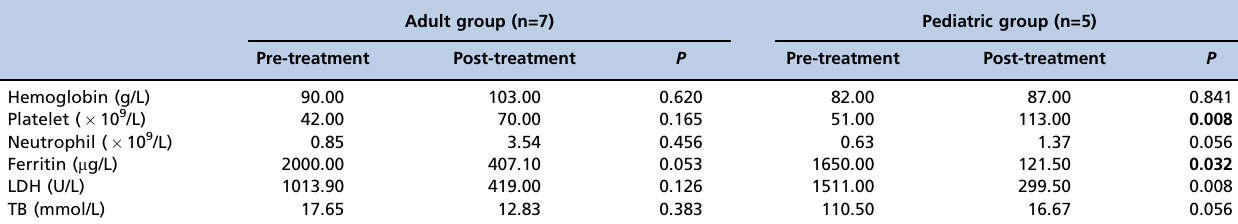
Table 3 - Changes in laboratory findings between diagnosis and after 2-3 weeks of treatment with the HLH-2004 protocol in adult and pediatric patients (medians). Adult group (n=7) Pediatric group